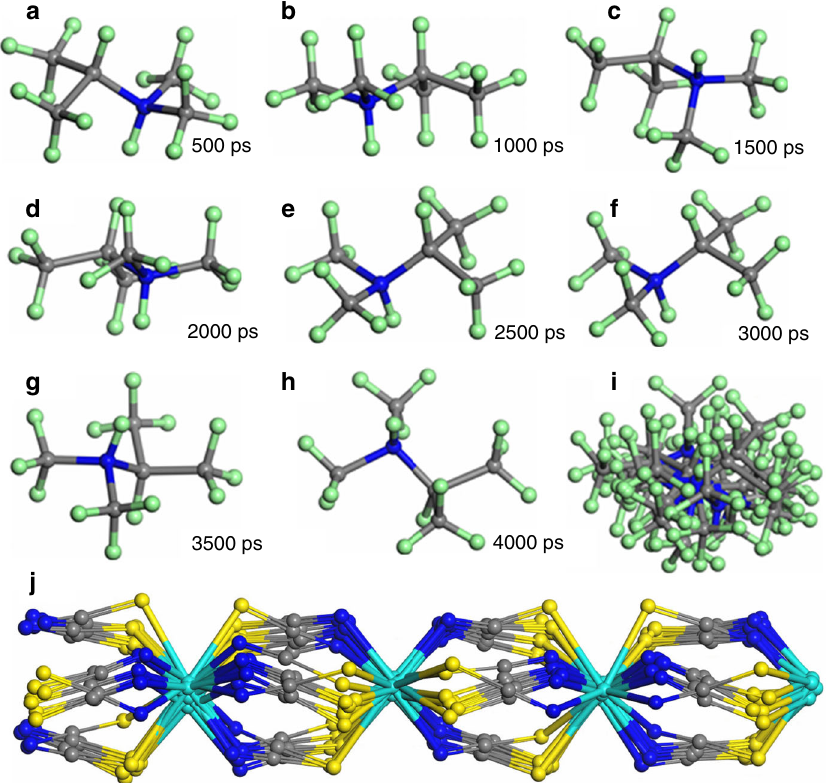
Fig. 6 Constant-volume and temperature dynamic simulation for CP 1 at 363 K. a – h Local snapshots of a ( i -PrNHMe 2 ) + cation over the simulation time, showing the orientation changes. i Overlapping maps of the snapshots of ( a ) – ( h ). j The corresponding local snapshots of a {[Cd(SCN) 3 ] − } ∞ chain are also overlapped, to display its dynamics.